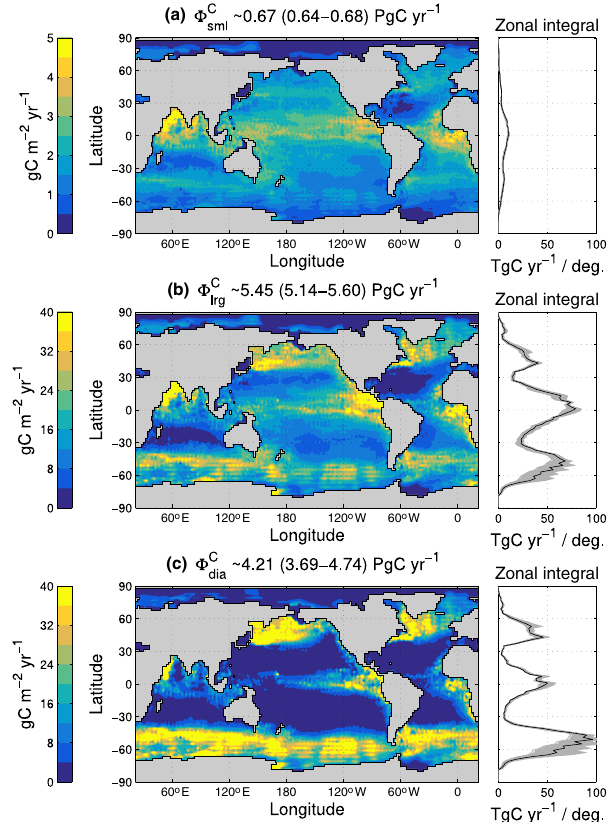
Figure F1. Local export production (maps on left) and its zonal integral (curves on the right) expressed in carbon units (using C : P = 106 : 1). Maps are shown for our typical state estimate, while we plot the zonal integral of each family member in grey and the typical state estimate in black. The export productions are plotted for each phytoplankton functional class: small (top plots, a ), large (middle plots, b ), and diatom (bottom plots, c ). Note the different color scale for the small class. The globally integrated exports for the typical estimate are indicated in the plot titles together with their ranges across the family of estimates in